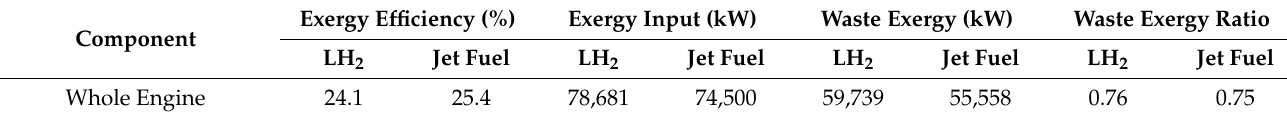
Table 6. Exergy assessment and comparison for LH 2 and jet